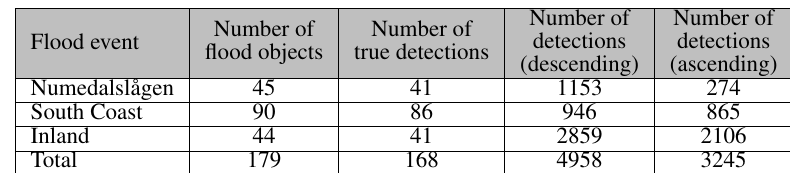
Table 4. Pixel-wise flood detection metrics.